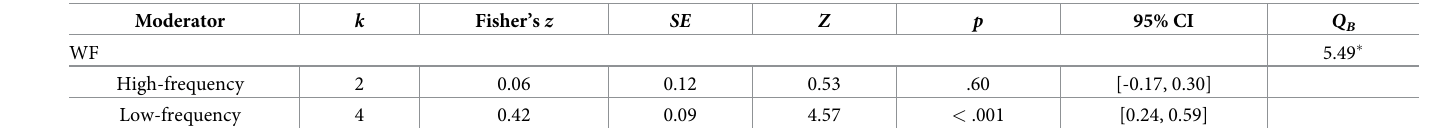
Table 4. Moderator (subgroup) analysis